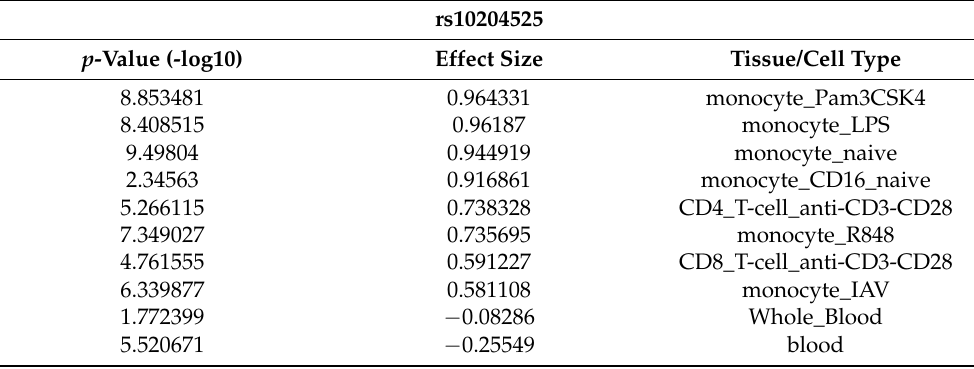
Table 8. The eQTL effect size and significance for PDCD1 rs10204525 and PD-1 expression in indicated cell types, with the variant significantly associated with increased PD-1